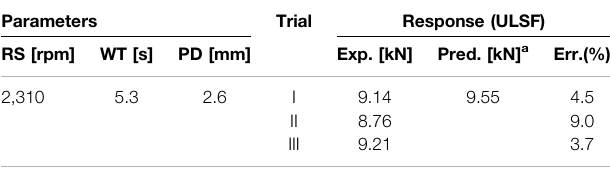
TABLE 5 | Validation experiments for predicted maximum